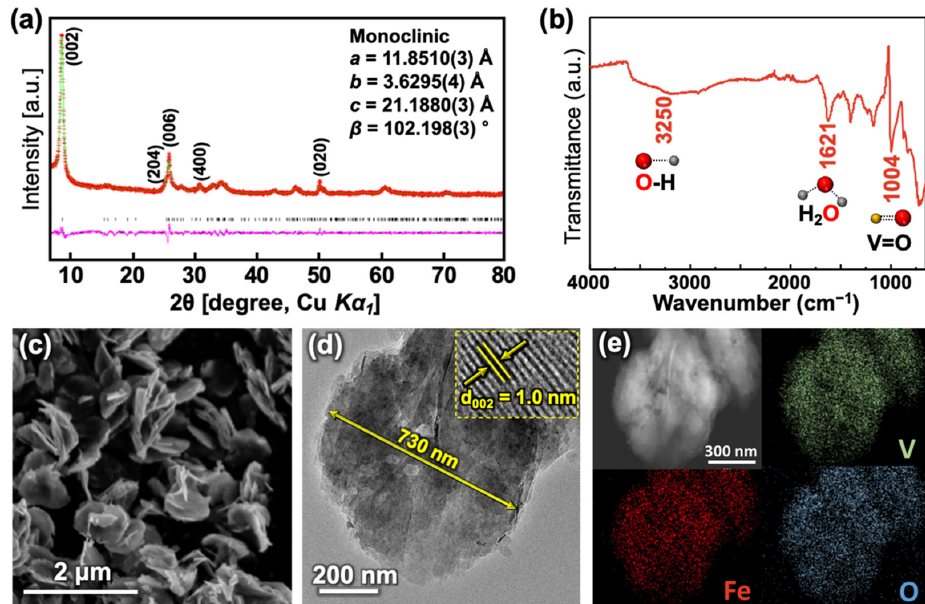
Figure 1. ( a ) Powder X-ray Le Bail profile, ( b ) FTIR spectrum, ( c ) SEM image, ( d ) magnified TEM image (inset: lattice fringe for d 002 ), and ( e ) EDX elemental mappings for the pristine FeV 3 O 9 ∙ 1.2H 2 O sample.